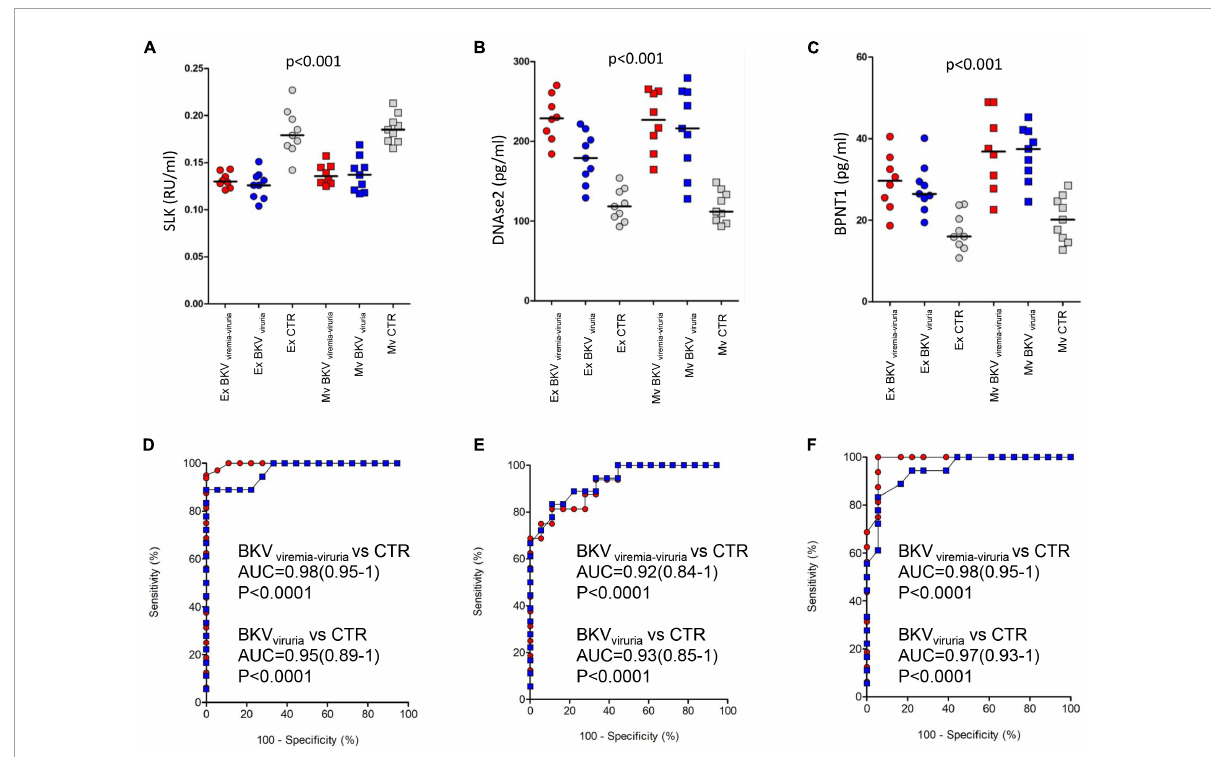
FIGURE7 ELISA of STE20 Like Kinase (SLK), Deoxyribonuclease 2 (DNASE2), and 3’(2’)5’-bisphosphate nucleotidase 1 (BPNT1). Plots show the median (black line) obtained from each duplicate measurement of (A) SLK, (B) DNASE2, and (C) BPNT1 in exosomes (circle) and microvesicles (square) isolated from urine of control (gray) and patients with BK viruria alone (blue) and BK viruria and viremia (red). Patients with BKV infection have a significant lower level of SLK compared to CTR in both extracellular vesicles. The opposite trend is observed for DNASE2 and BPNT1. ROC curve analysis for (D) SLK, (E) DNASE2, and (F) BPNT1 ELISA comparing control and patients with BK viruria alone (blue square) and BK viruria and viremia (red